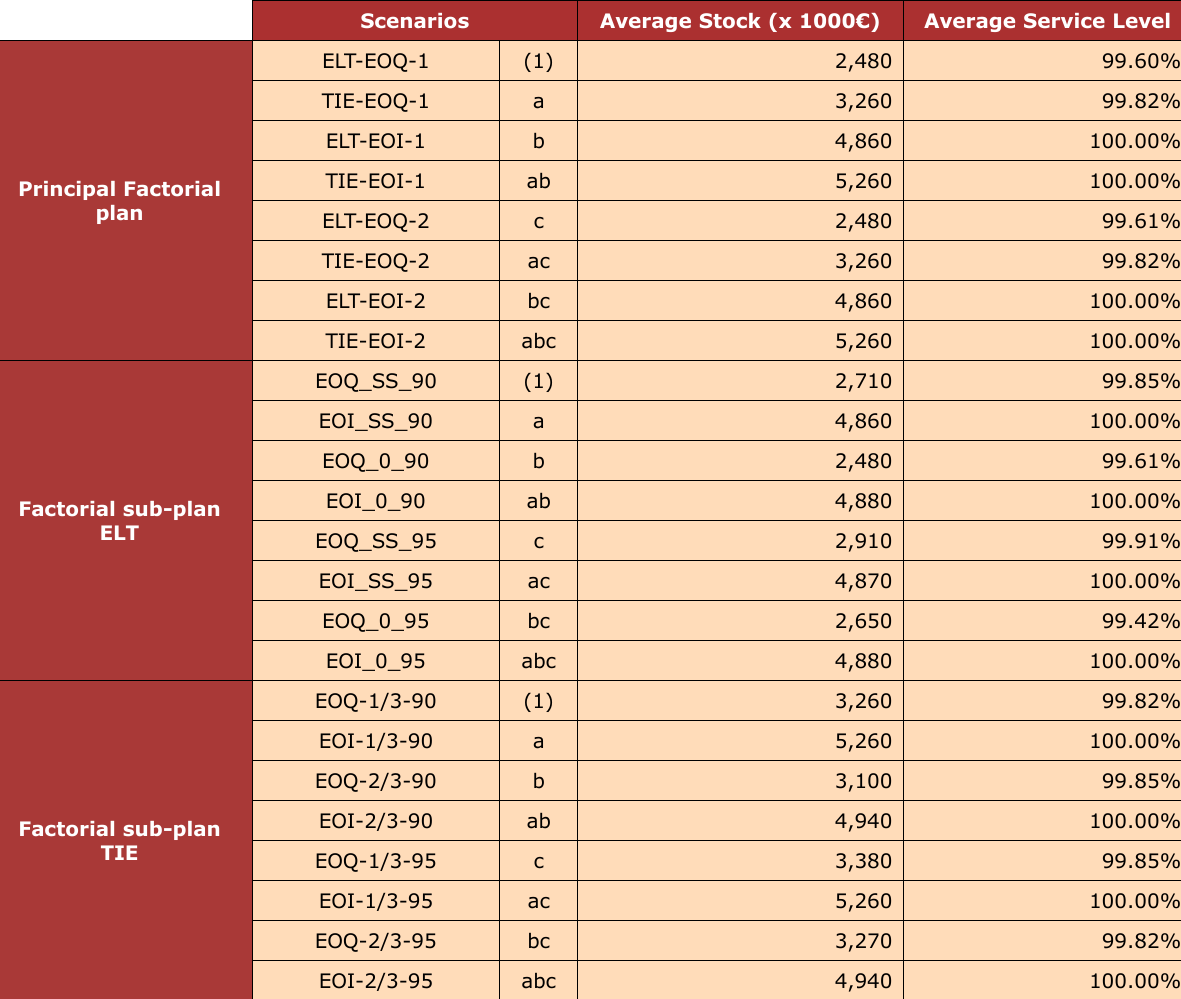
Table 1. Results of